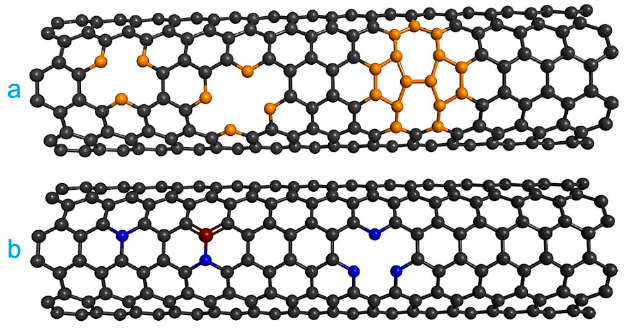
Figure 3. Defect engineering in CNTs. Types of ( a ) vacancies and ( b )